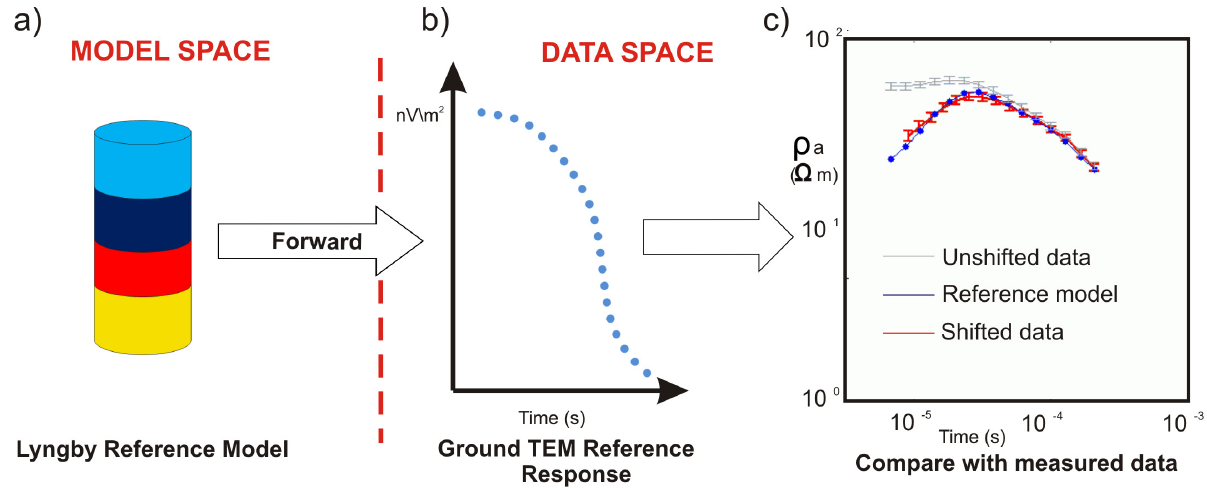
Figure 2. Simplified scheme illustrating the calibration procedure (following Foged et al. [2013]). (a) Reference 1-D resistivity model recov- ered from the Lyngby test site from which forward responses are calculated (b). (c) Calibration plot example for the ultra high repetition fre- quency. Gray curve is the raw collected TEM data. Blue curve is the reference response. Red curve is the calculated TEM response after amplitude and time shift factors correction. The TEM responses are plotted as late-time apparent resistivity for easier